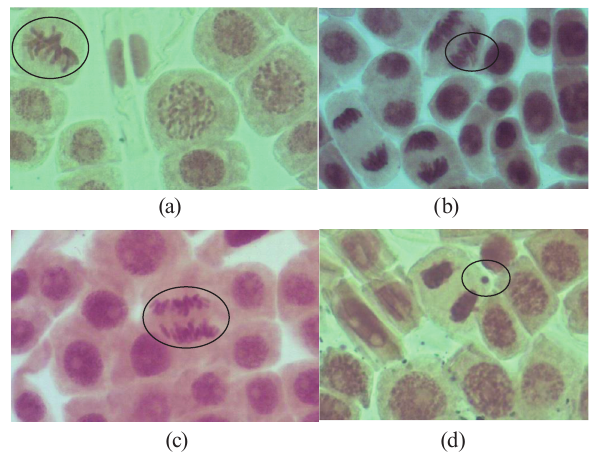
Figure 3 Chromosomal aberrations in onion root meristem cells: adhesion in metaphase (a), leading in anaphase (b), disorganization in anaphase (c), and a micronucleus in telophase (d)